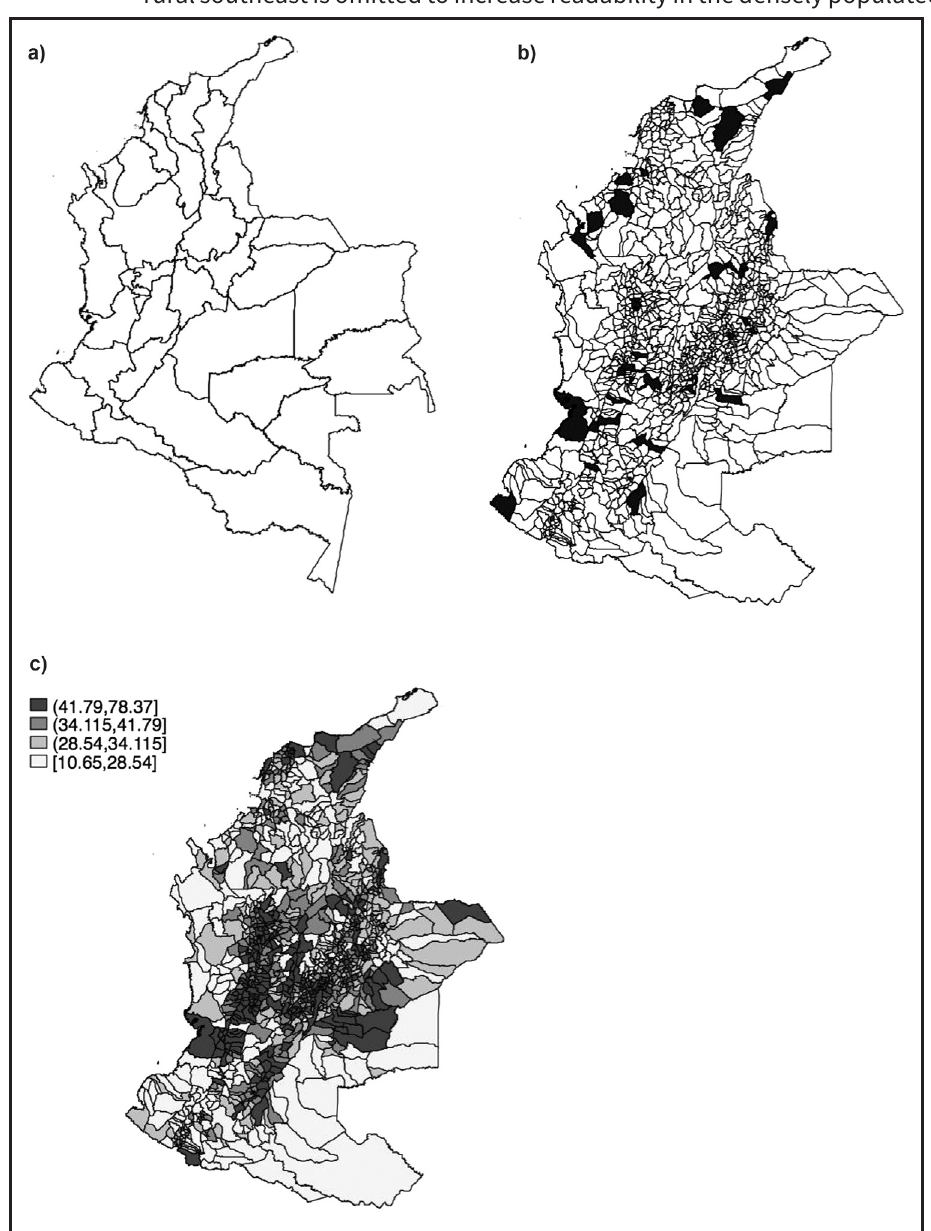
Maps of Colombia: a) Colombia’s departments; b) Colombia’s municipalities in black, those which were assigned autonomy over education in 2002; c) Distri- bution of Municipal Development Index in 2001. Note: In maps b) and c), the rural southeast is omitted to increase readability in the densely populated